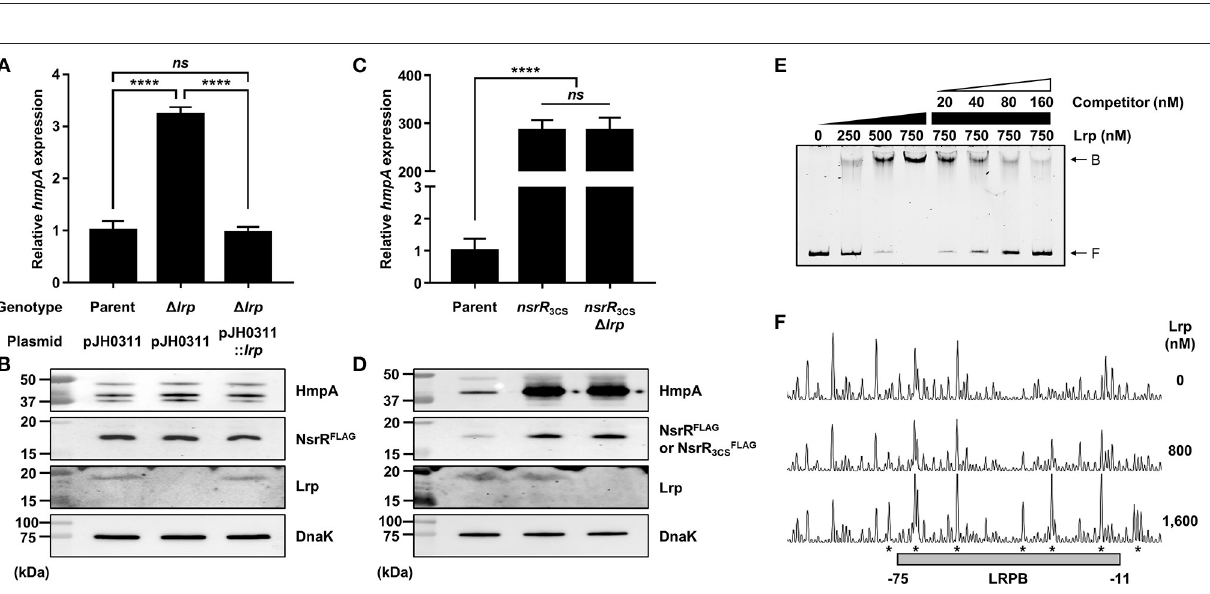
in an Lrp concentration-dependent manner ( Figure 6E ).